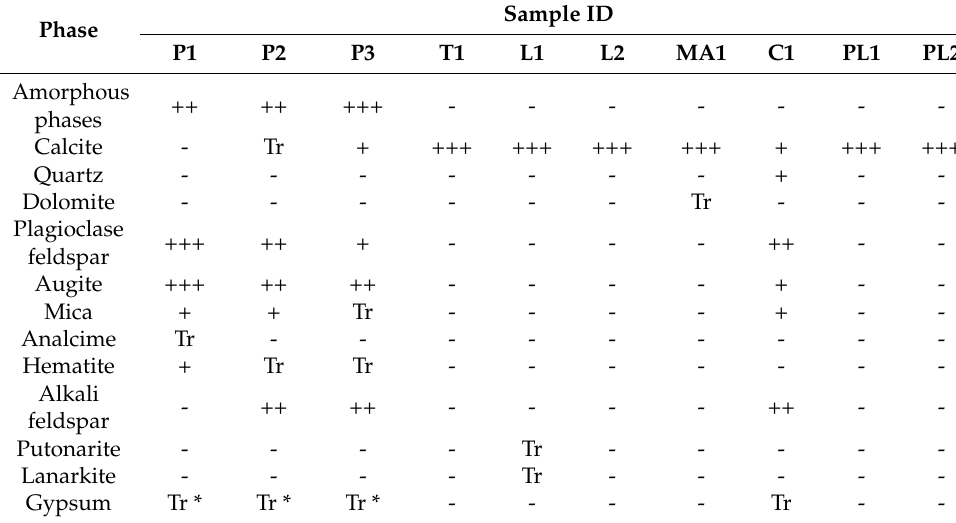
Figure 15. Microphotographs of: ( a ) sample P1, pumice; ( b ) sample T1, travertine; ( c ) sample L2, limestone; ( d ) sample MA1, marble; ( e ) sample C1, ceramic; ( f ) sample PL1, plaster; ( g ) Micas represented accessory minerals. All the microphotographs are at plane polarized light, except than c and d2 that are at crossed polarized light. All the samples are investigated at 4× magnifications. Line red bars = 1 mm.